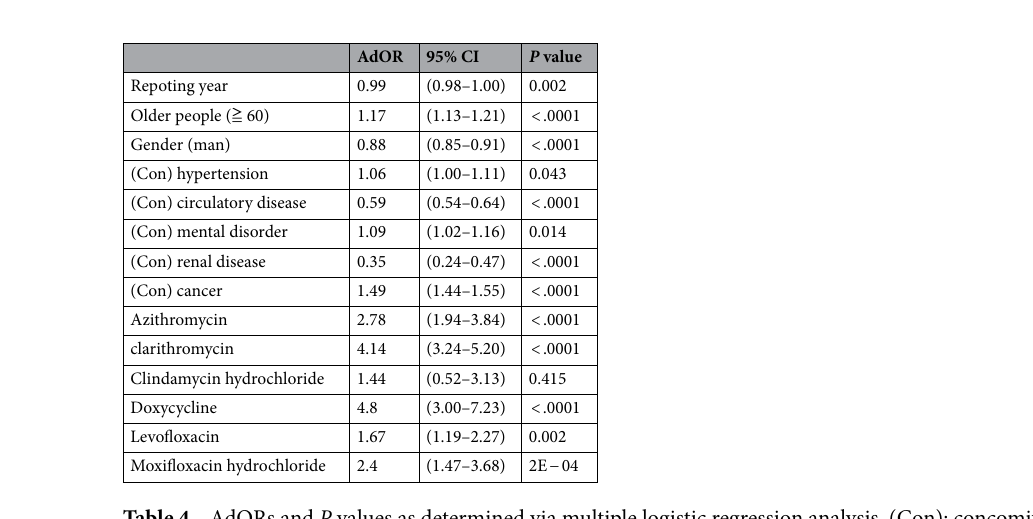
Table 4. AdORs and P values as determined via multiple logistic regression analysis. (Con): concomitant diseases.